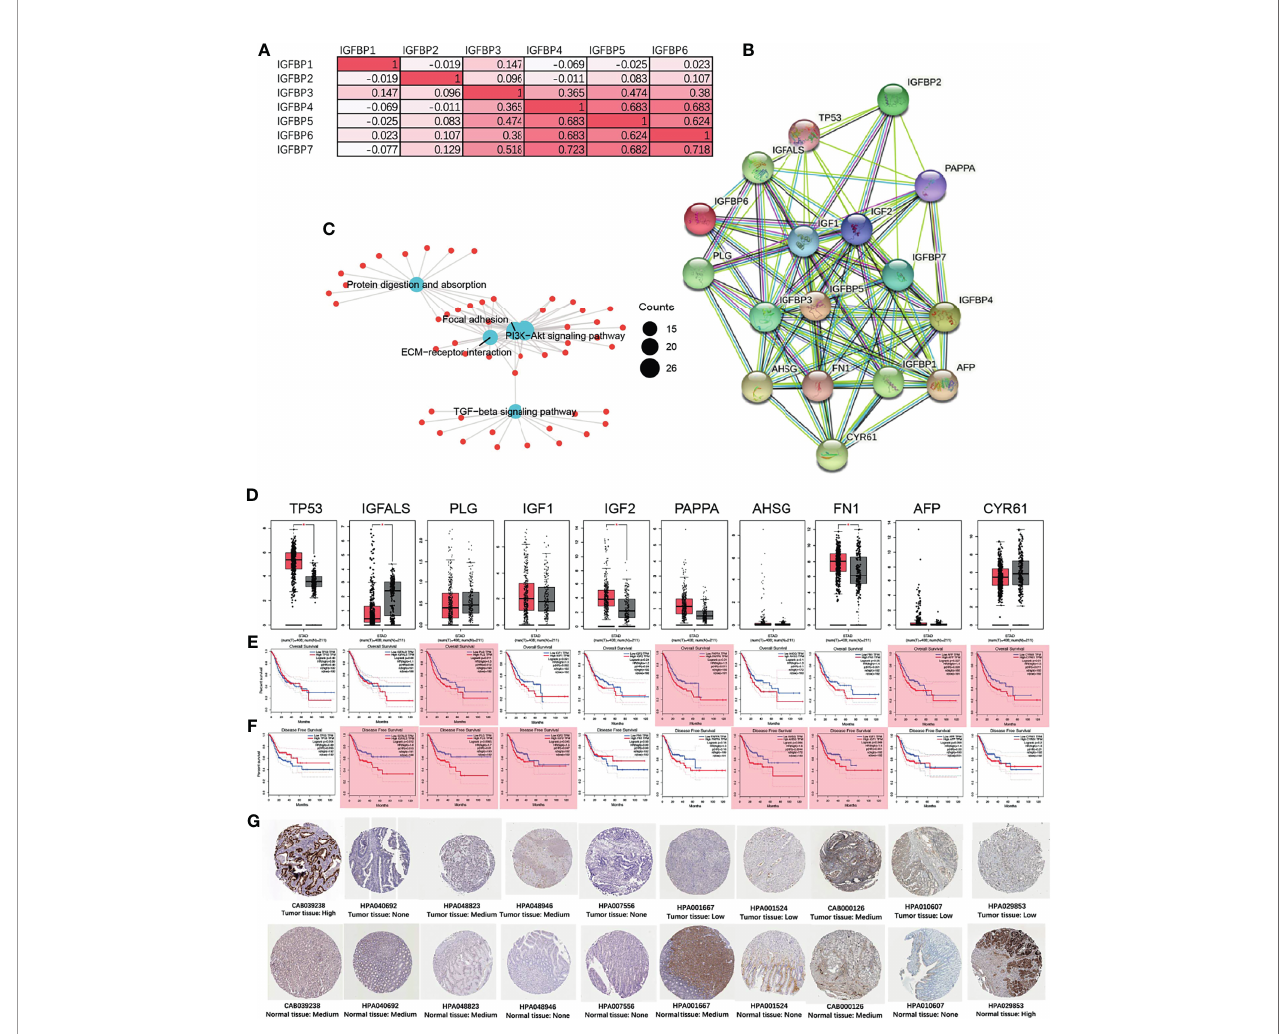
FIGURE 6 | IGFBP1 – 7 gene expression correlation and protein network interactions (STRING), and hub gene expression and survival analysis of STAD based on GEPIA database. (A) Correlations among IGFBP1 – 7 in STAD patients from the TCGA database. (B) PPI network of IGFBP1 – 7. (C) GO analysis of interacting proteins from (B) . (D) Expression levels of 10 hub genes of IGFBP1 – 7 in STAD patients. (E) Overall survival analysis for the 10 hub genes in GEPIA database. (F) Disease-free survival analysis for the 10 hub genes in the GEPIA database. *p < 0.05 (bar plot); p < 0.05 marked as red shadow (survival analysis). (G) The